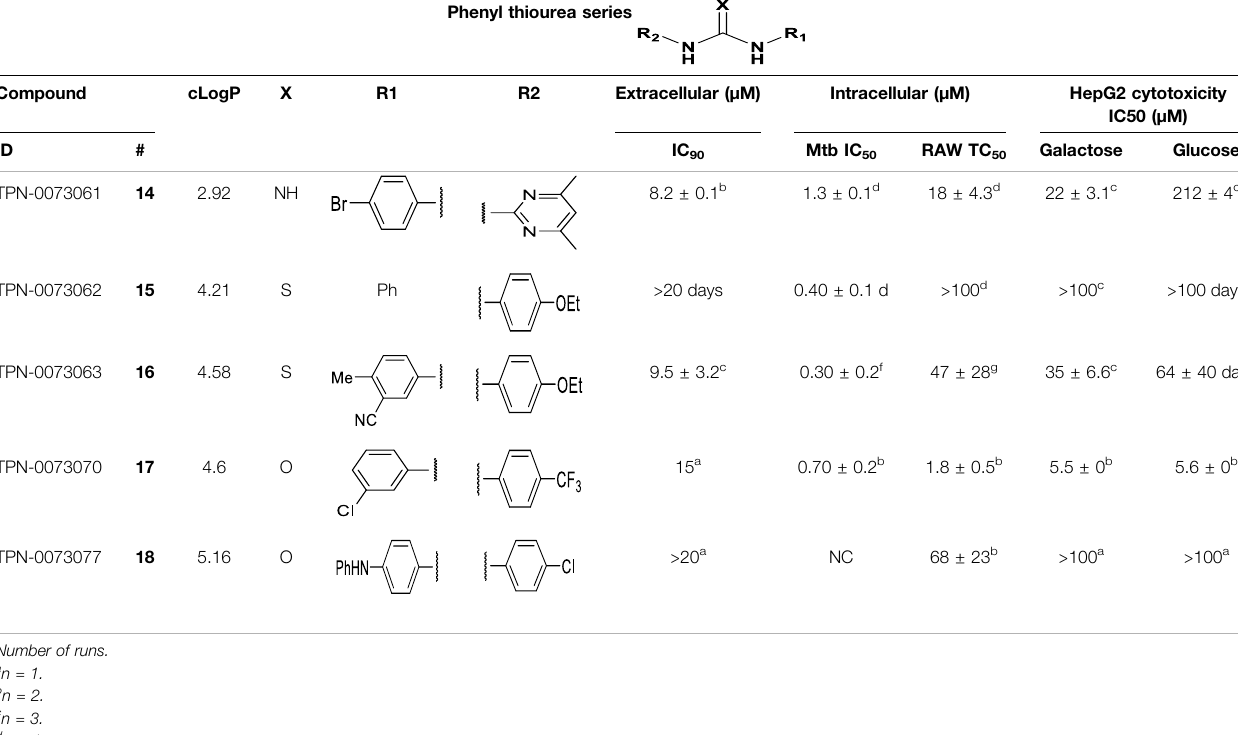
TABLE 5 | Catalog structure-activity relationship of the PTU series.